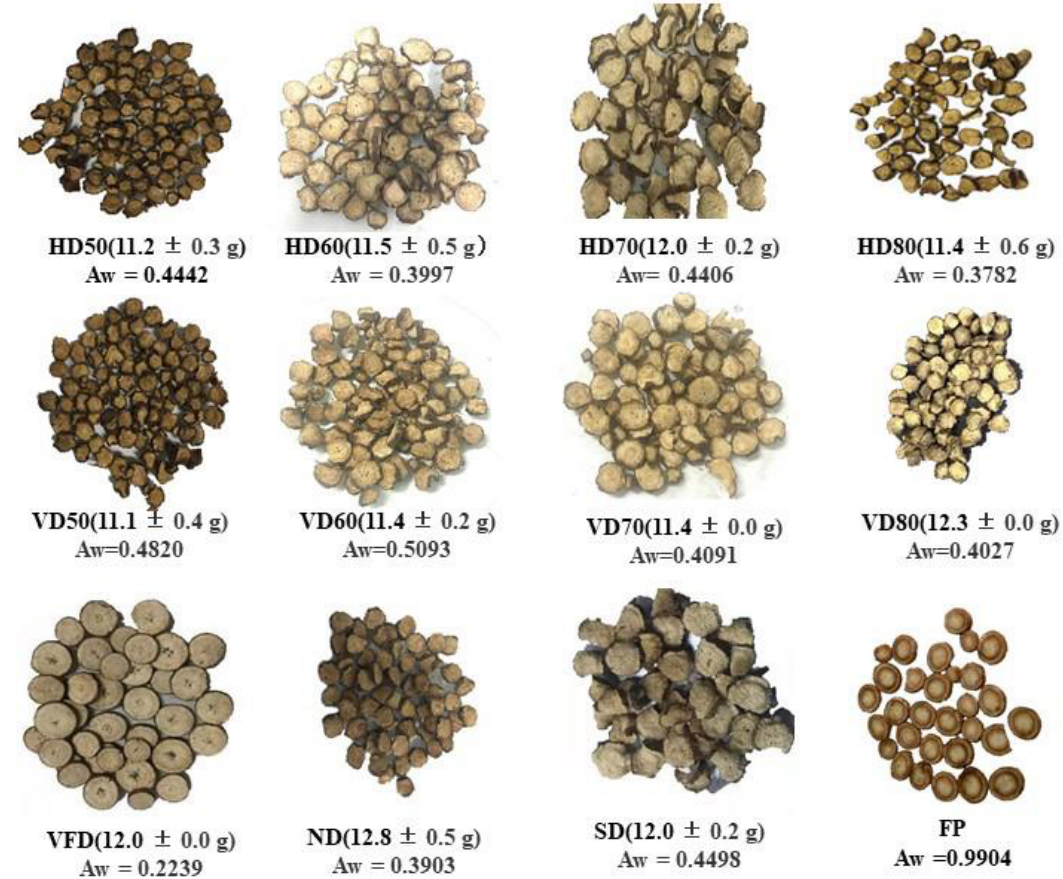
Figure 1. Appearance and dry weight of dried burdock root treated by different drying methods. ( n = 3; the fresh weight for burdock is 60 g, and the dry weight are expressed as Mean ± SD; HD50–80 means hot air drying at 50–80 ◦ C, VD50–80 means vacuum drying at 50–80 ◦ C, VFD means vacuum freeze drying, ND means natural drying, SD means sun light drying, FP means fresh pieces and Aw means activity water).